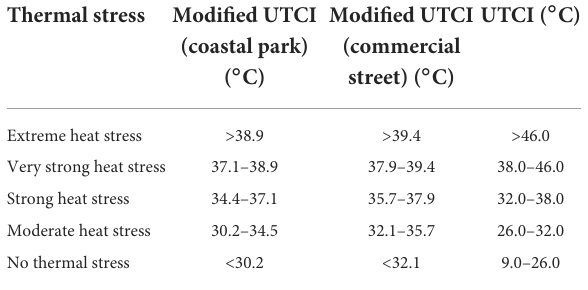
TABLE 4 UTCI calibrations for different stress categories.